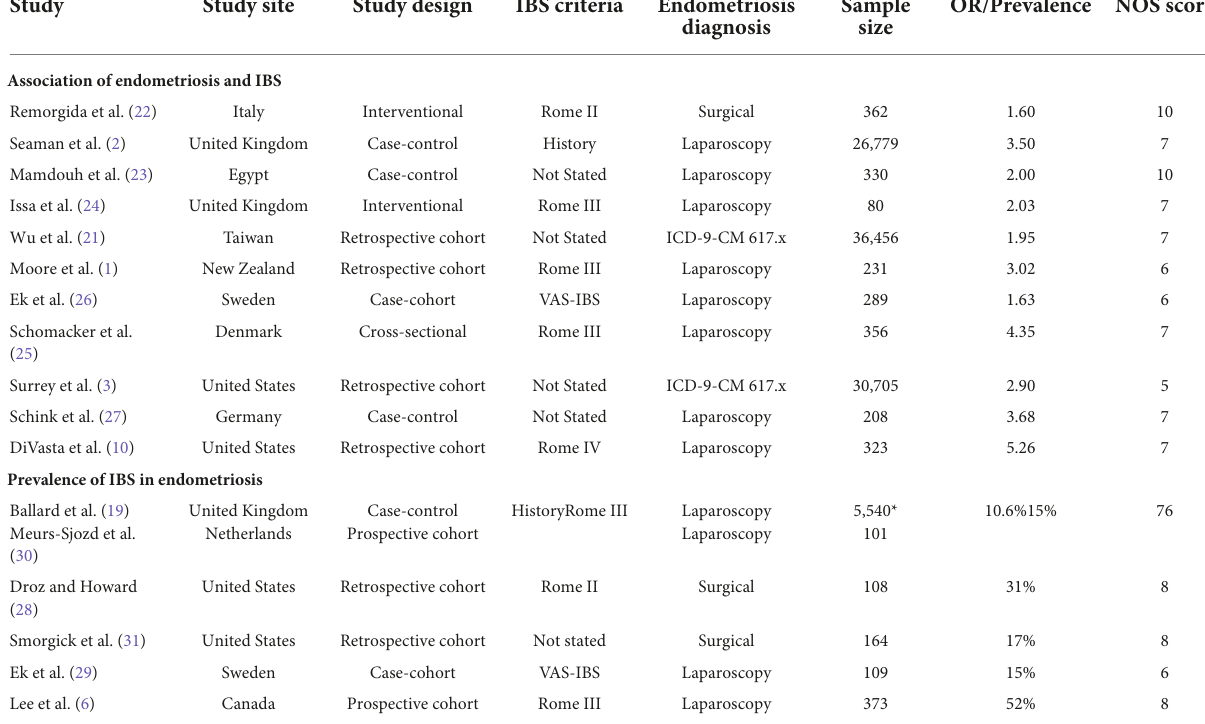
TABLE 1 Included study characteristics.